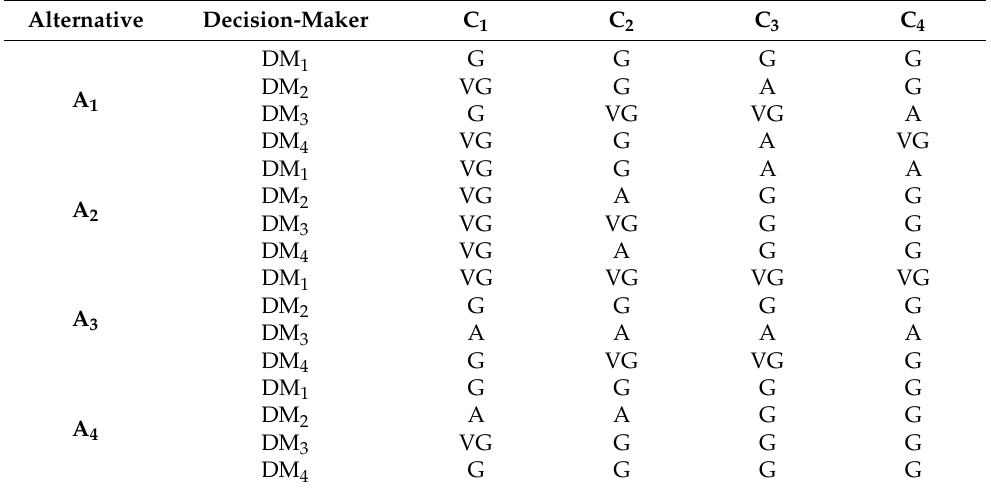
Table 2. Linguistic rating for four attributes for the four available alternatives by decision-makers. Alternative